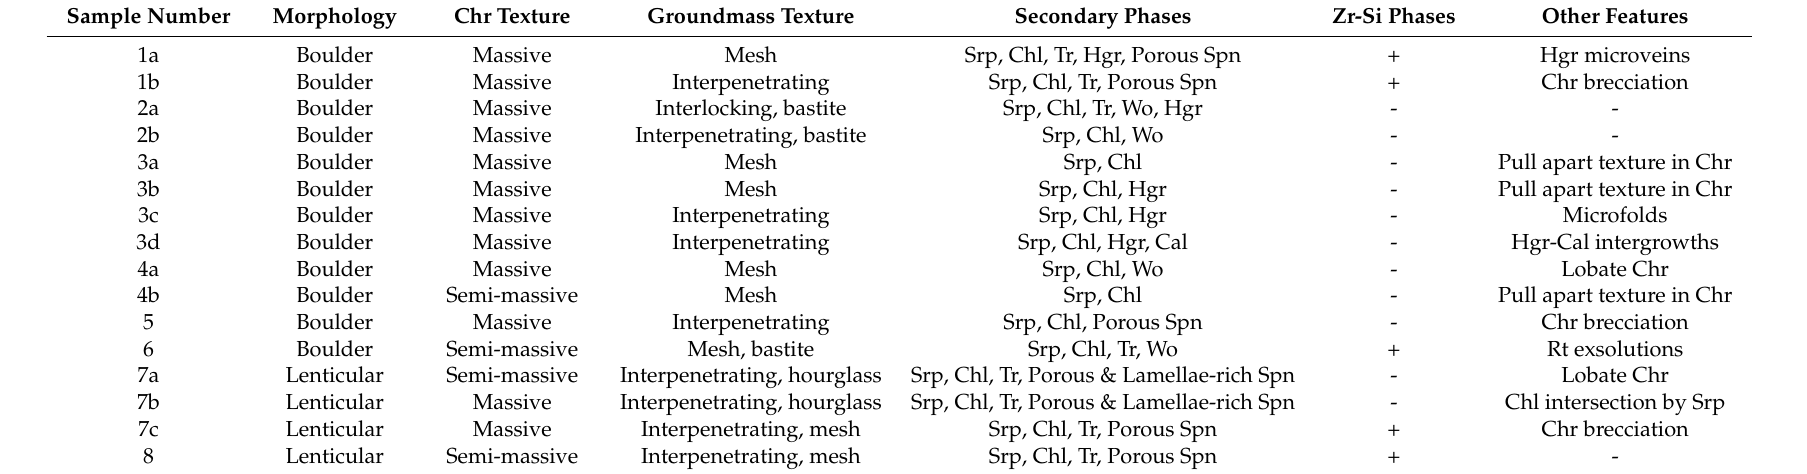
Table A1. Summary of the main petrographic characteristics of the studied chromitites. Abbreviations: Cal = calcite; Chl = chlorite; Hgr = hydrogrossular; Ser = serpentine; Spn = Spinel; Tr = tremolite; Wo = wollastonite. The symbols: + and -, denote the accessory presence and absence of zircon,